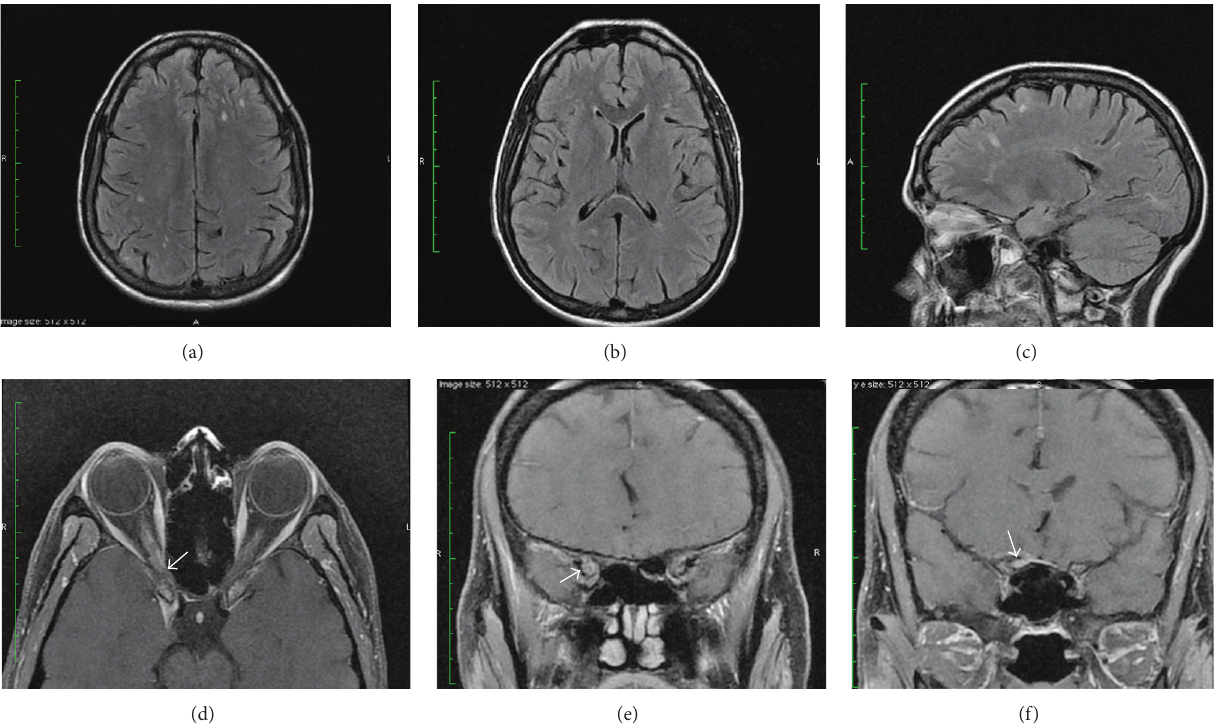
Figure1:BrainMRIT2FLAIRaxial(a,b)andsagittal(c)scansmadeatthetimeofpresentationshowingmultiplenonenhancinghyperintense lesions in the periventricular, deep, and subcortical white matter. MR contrast-enhanced axial (d) and coronal (e, f) sequences of the orbit. The arrows pointed to a small extra-axial lesion with peripheral enhancement extending into the optic canal and apex of orbits surrounding the optic nerve with a small amount of fat stranding this